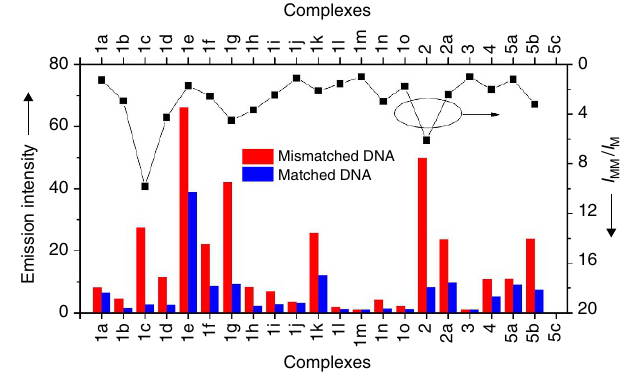
Figure 2 | Emission responses of Pt(II) complexes to matched and mismatched DNA. A summary of emission intensities (at near level off) of different Pt(II) complexes towards mismatched and matched DNA and the emission intensity ratios ( I MM / I M